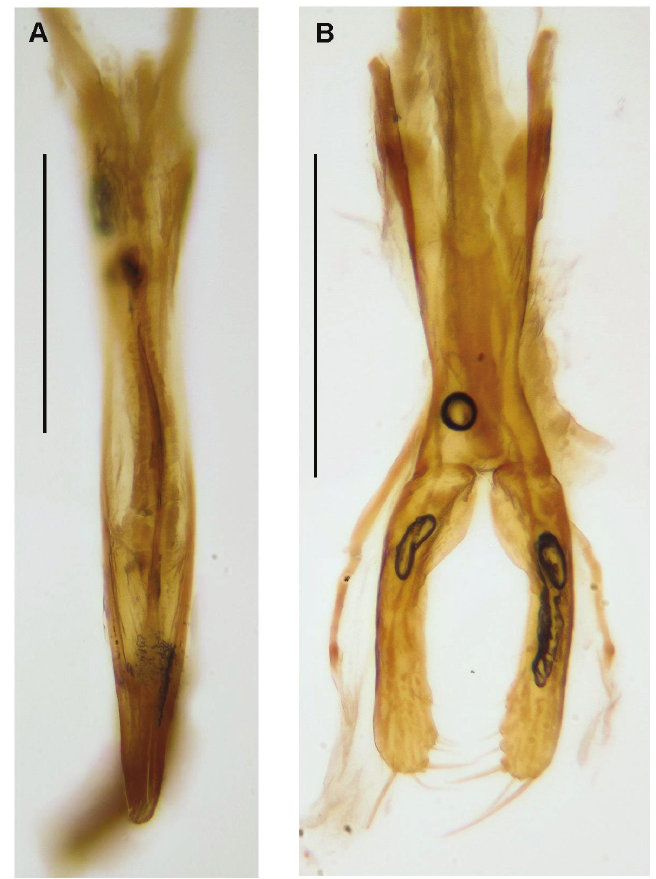
Fig. 3. Psammoecus luchti Karner, 2012. A . Median lobe. B . Parameres. Scale lines = 0.2